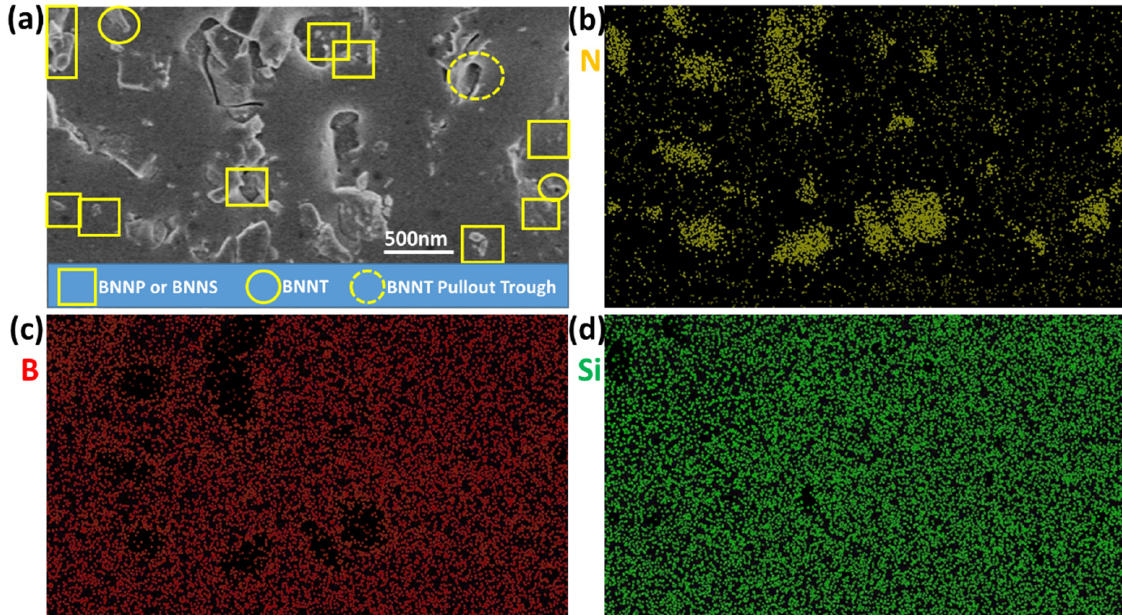
Figure 7. SEM image ( a ) and eds mapping ( b – d were N, B and Si, respectively) of cross-section of BN/PiG composite.